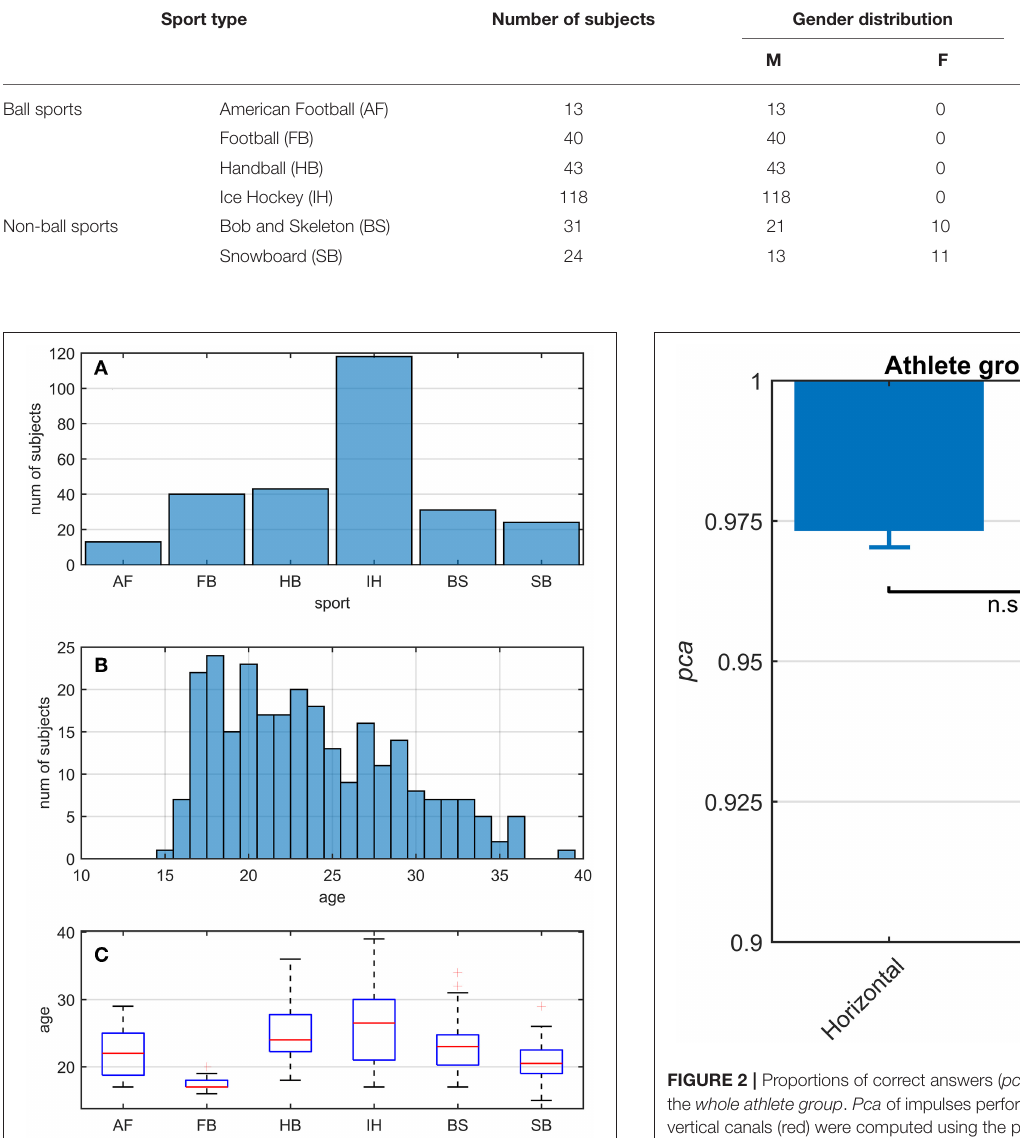
TABLE 1 | Sport and age distributions of athletes.